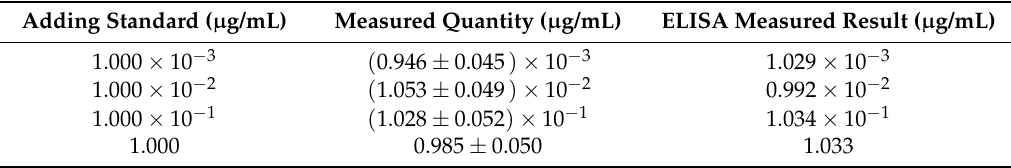
Table 2. Comparison of malachite green (MG) test results in experimental samples. ELISA–enzyme- linked immunosorbent